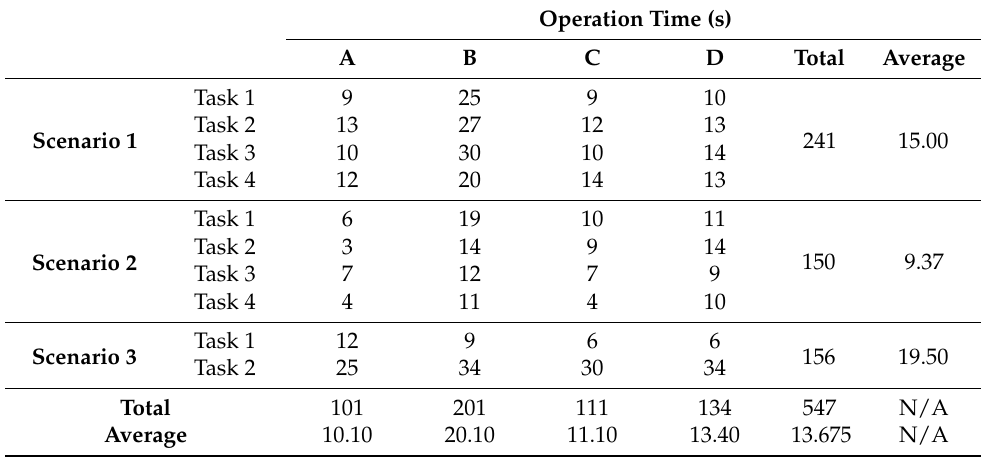
Table 7. Field test results for Method